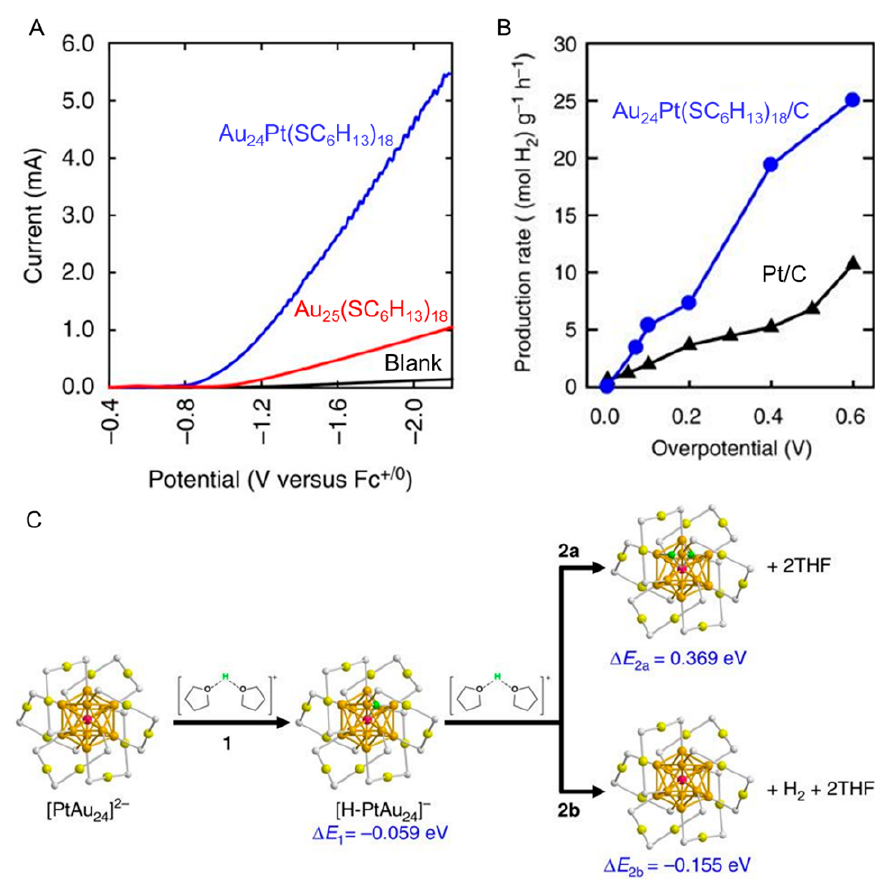
Figure 2. ( A ) HER polarization curves of Au 25 (SC 6 H 13 ) 18 - or Au 24 Pt(SC 6 H 13 ) 18 -adsorbed glassy carbon electrode (GCE), or GCE. ( B ) H 2 production rates per mass of metals in the catalyst of Au 24 Pt(SC 6 H 13 ) 18 / C (blue circles) and Pt / C (black triangles) electrodes. ( C ) DFT calculation results for Au 24 Pt(SCH 3 ) 18 . Color code: golden = Au core; olive = Au shell; purple = Pt; green = adsorbed